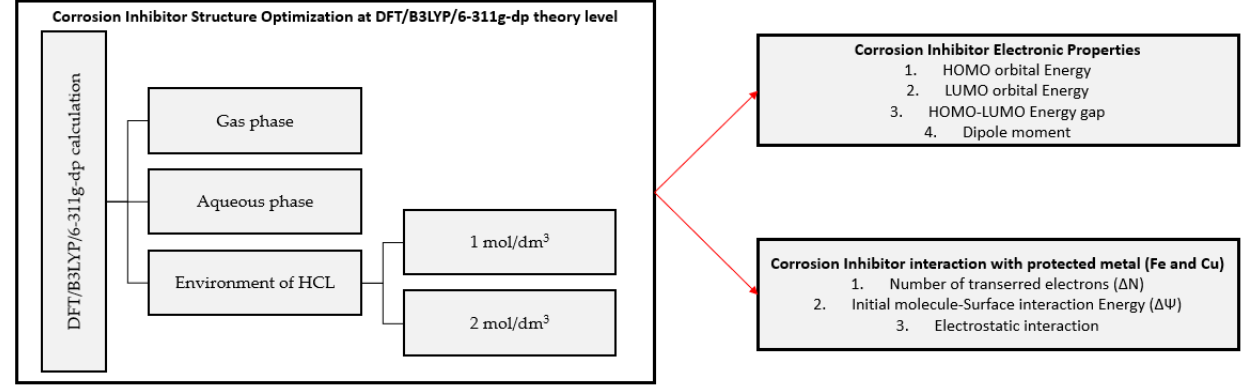
Scheme 2. Overall scheme of performed DFT calculations.